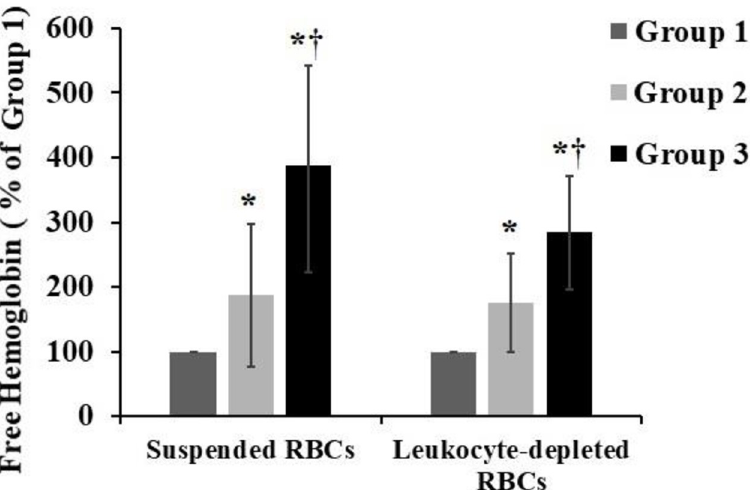
Fig 4. FHb contents were determined by a test kit according to the manufacturer’s instructions. Group 1 were the 1st day fresh-collected RBCs, group 2 was the 14th day RBCs with resting refrigerated storage, and group 3 was the 14th day RBCs after plateau transportation. The data represent mean ± SD from five RBCs samples in each group. � p < 0.05 compared to group 1; †p < 0.05 compared to group 2.